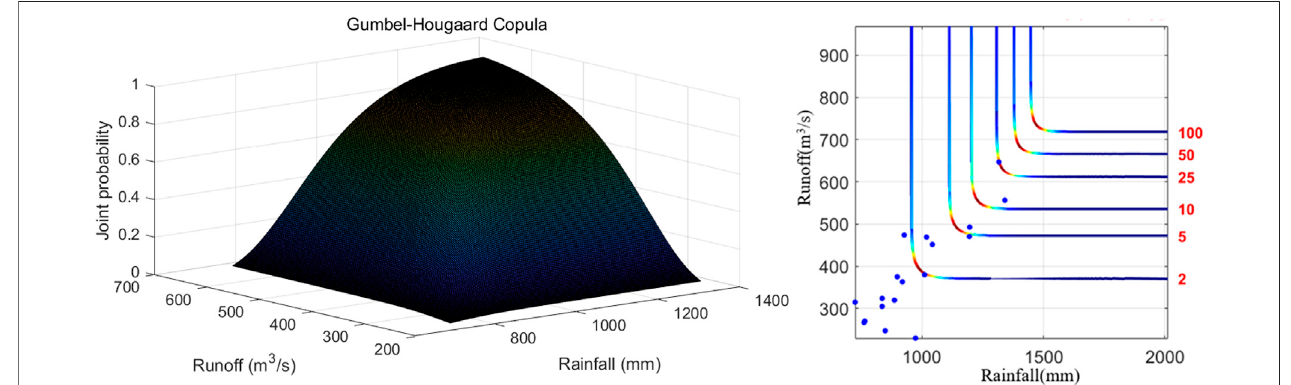
FIGURE 9 | Joint probability density and return periods of rainfall and runoff.